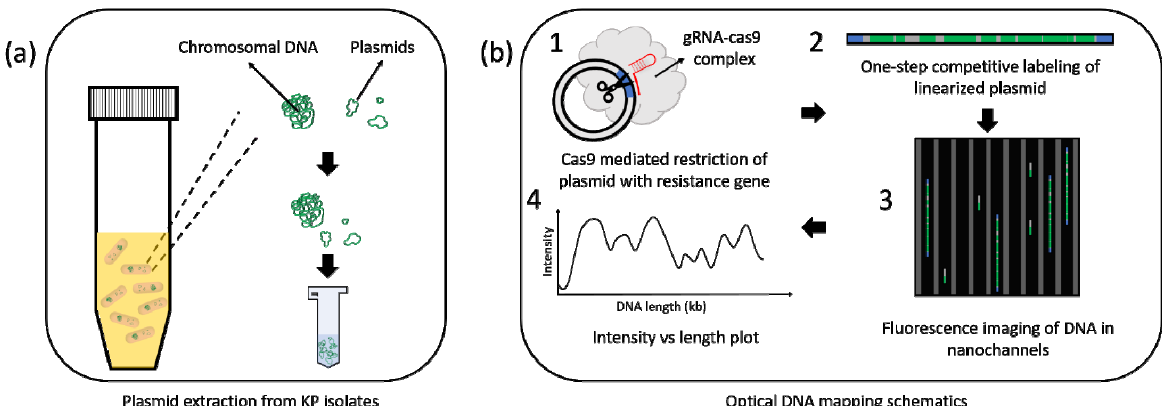
Figure 1. ODM schematics. ( a ) Plasmids extracted from bacteria collected from patients (Materials and Methods). ( b ) 1. Restriction of plasmids with Cas9, targeting bla NDM-1 , bla CTX-M-15 or bla OXA-232 gene. 2. One-step competitive labeling of plasmids using YOYO-1: Netropsin. 3. Imaging of stretched DNA molecules in nanofluidic devices. 4. Image analysis to obtain barcodes or intensity profiles of DNA molecules.